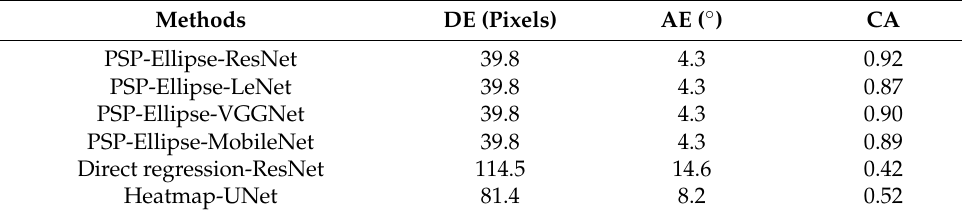
Table 6. Comparison results of several endpoint detection